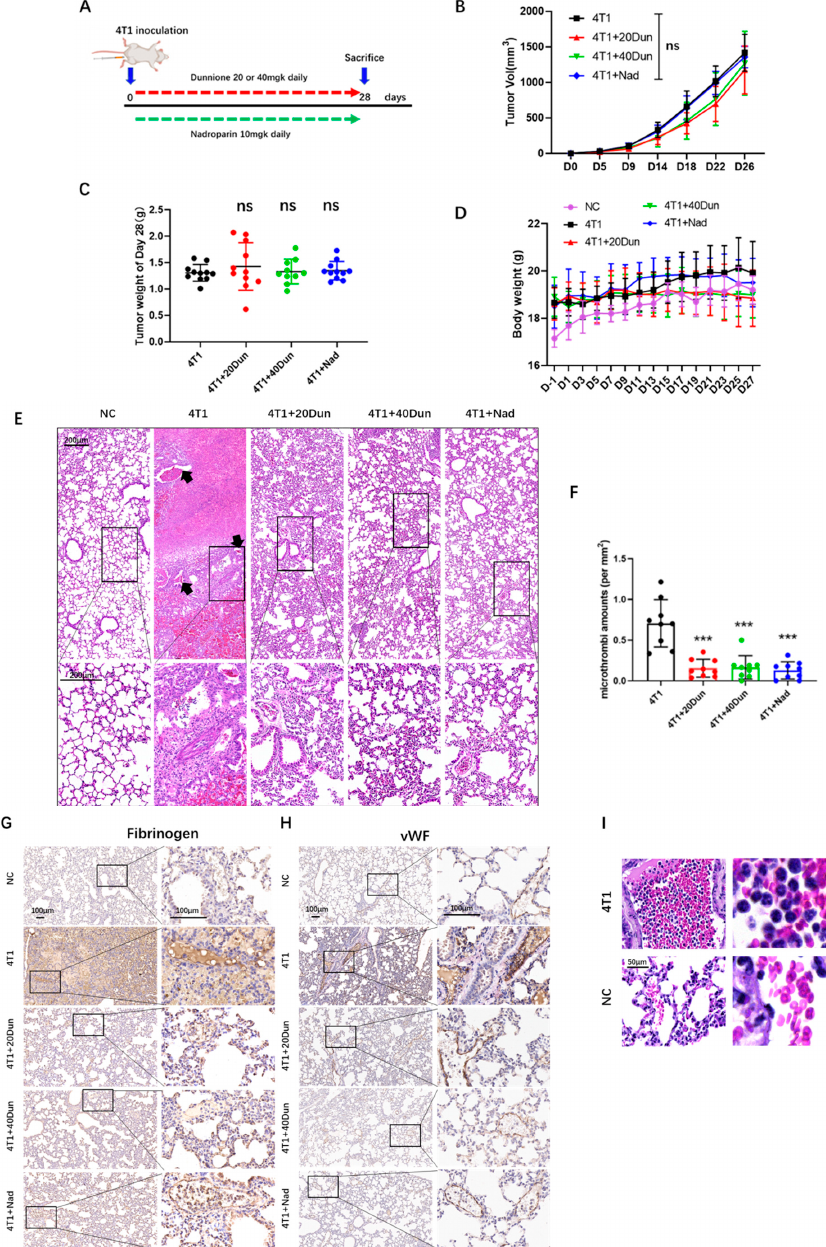
Figure 1. Dunnione inhibits 4T1 breast cancer-associated pulmonary thrombosis. ( A ) Diagram depicting the treatment schedule for the 4T1 breast cancer-associated thrombosis mouse model. Dunnione (dissolved in corn oil) and nadroparin were administrated daily, orally and subcutaneously. ( B ) Volume changes of orthotopically inoculated tumors in each group on the day of tumor injection ( n = 8–11 per group). ( C ) Comparison of tumor weight of mice 28 d after tumor inoculation ( n = 10–11 per group). ( D ) Body weight changes in the tumor-bearing mice and normal control mice in each group. Weight was measured every other day. ( E ) Representative hematoxylin and eosin ( E,H ) staining images of lung sections in each group. Black arrows indicate the thrombi ( n = 8–11 per group). Scale bar, 200 μ m. ( F ) Microthrombi counts per mm 2 of lung section of each group at 28 d after tumor inoculation ( n = 9 per group). ( G , H ) Representative immunohistochemistry (IHC) images of fibrinogen ( G ) and von Willebrand Factor (Vwf) ( H ) in the lung sections of each group ( n = 4). Scale bar, 100 μ m. ( I ) Comparison of pulmonary vessels by H&E staining in 4T1 tumor-bearing mice and normal mice. Scale bar, 50 μ m. NC (normal control): tumor-free mice. p -values were obtained by one-way analysis of variance (ANOVA). Data represent the mean ± standard deviation (SD). Significance as compared to the samples of the 4T1 group. ns, not significant; *** p < 0.001.